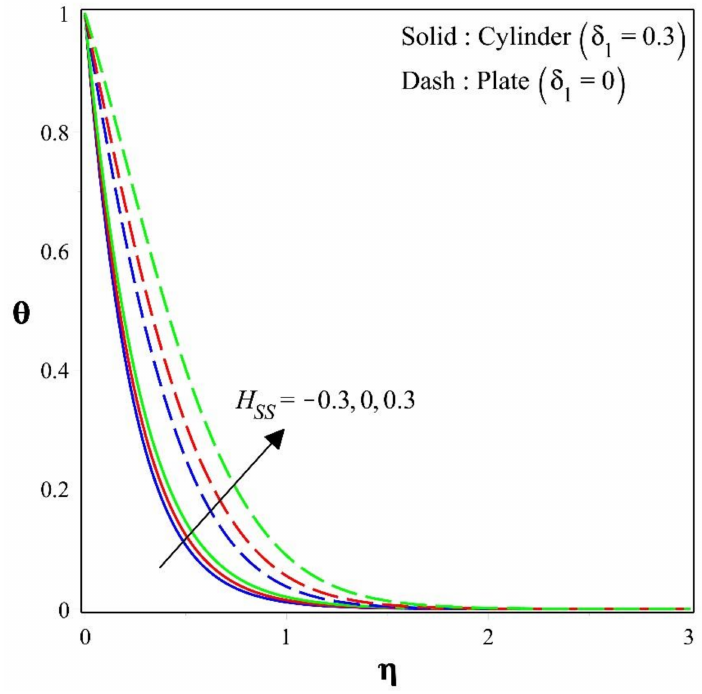
Figure 8. The role of heat source/sink parameter on temperature profile (keeping P m = γ 1 = 0.1, ζ = 30 0 & φ 1 = φ 2 = φ 3 = 0.01).